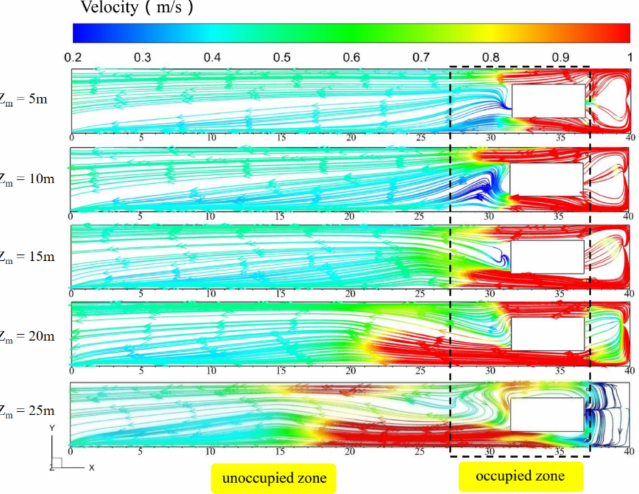
Figure 12. Airflow velocity distributions and airflow streamlines for different Z m .